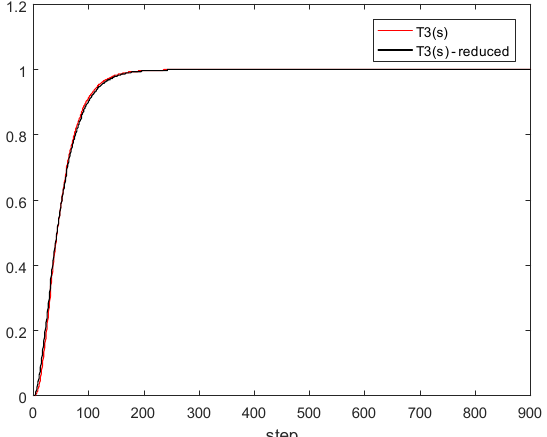
Figure 12. Comparison of original and T 3 and after order reduction (black line)—simulation of 900 time-steps.